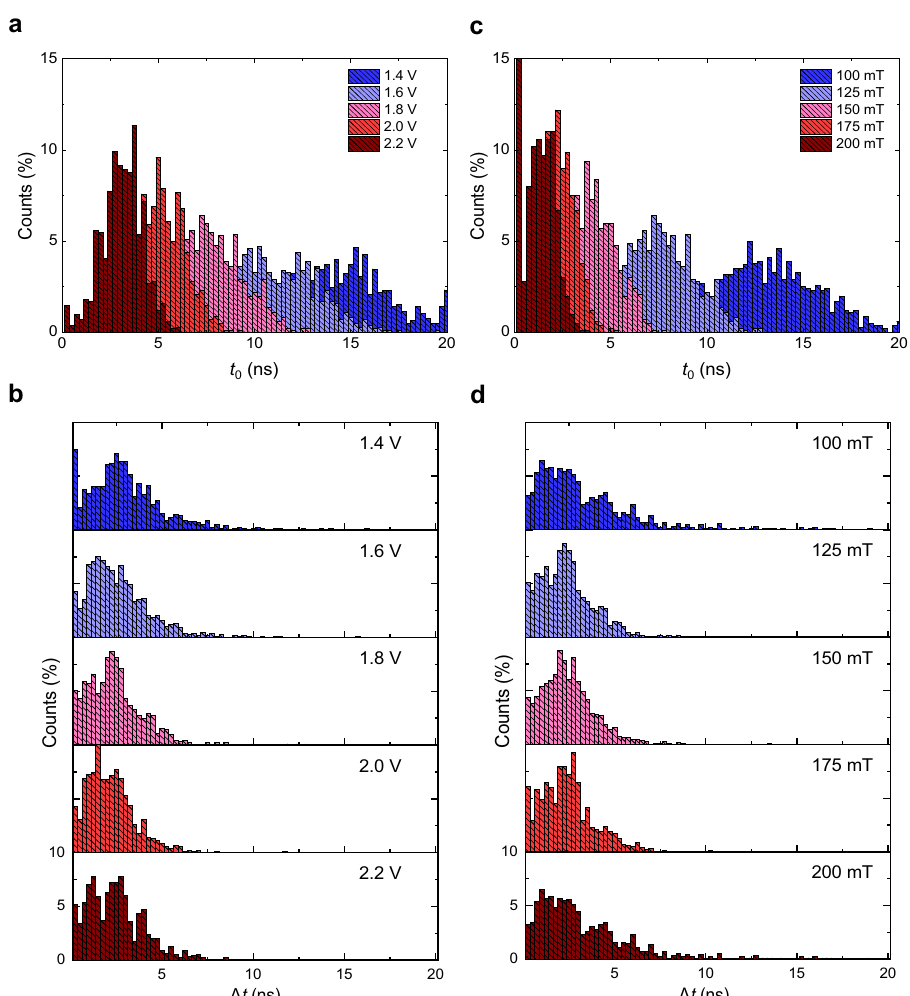
Fig. 4 Distribution of nucleation and transition times. a , b Percentage distributions of the nucleation time t 0 and transition time Δ t for different amplitudes of 20-ns long voltage pulses, extracted from the fi ts of the single-shot traces. At 1.4 V, the magnetization does not switch in 22.5% of the events; these events are not included in the plot. The in-plane fi eld is 125 mT. c , d Same as a , b for different in-plane fi elds at a constant pulse amplitude of 1.8 V. At 100 mT, the magnetization does not switch in 9.8% of the events. At 200 mT, the left-most bin includes 24% of the events. This is likely an artifact of the fi ts due to the limited signal-to-noise ratio of the traces, which causes dif fi culties in fi tting the dynamics close to the rising edge of the pulse. To ease the comparison, in all of the graphs the binning size is 250 ps, larger than the temporal resolution of 100